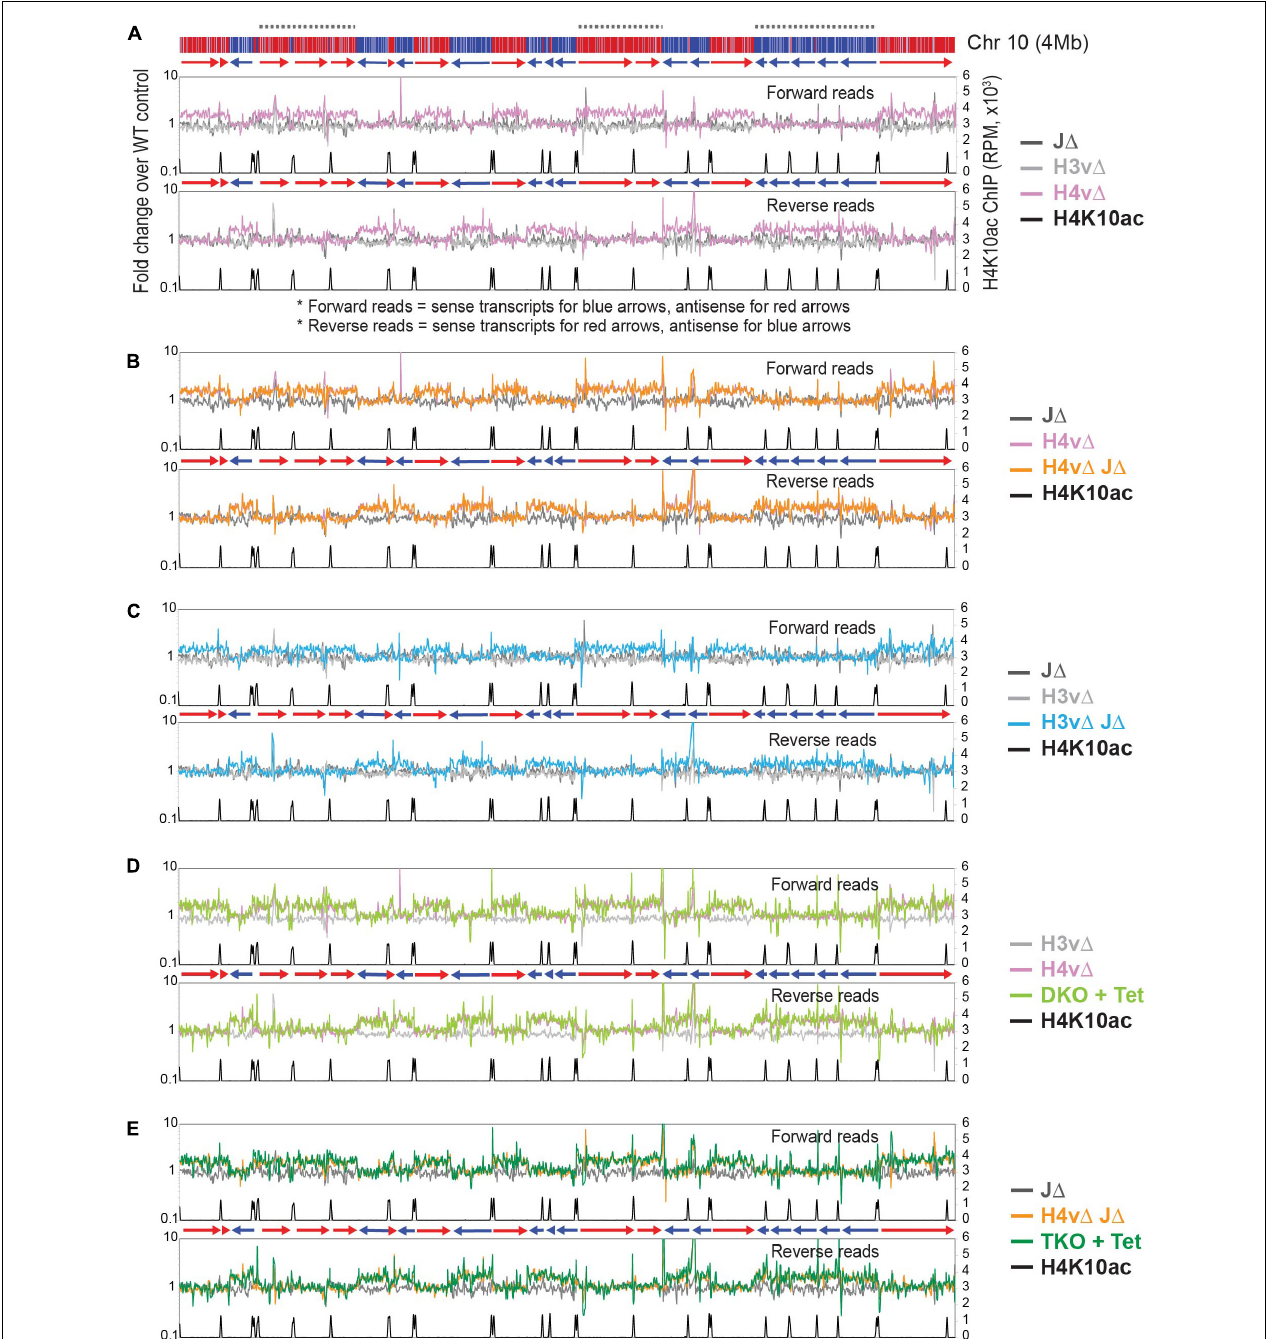
FIGURE 2 | H4v is the major transcription termination signal with a secondary role of H3v and J. Global transcription was examined by rRNA-depleted stranded RNA-seq and the sequence reads mapped to the T. brucei Lister 427 genome. Forward and reverse reads were analyzed separately with sliding windows (5-kb bin, 1-kb step). Forward reads represent sense transcripts in reverse orientation (blue arrows, blue PTUs moving from right to left) and antisense transcripts in forward orientation (red arrows, red PTUs moving from left to right). Fold changes of reads per million mapped reads (RPM) values between WT and each of KO mutant are plotted for all chromosomes. Chromosome 10 is shown as an example. Diagram of chromosome 10 is shown on top: PTUs are shown in red and blue bars with arrow heads indicating transcription direction. Dotted lines are regions containing multiple head-to-tail (HT) PTUs in the same direction. Primary y -axis is a fold change of RPM values of each mutant compared to WT. Secondary y -axis is RPM values obtained from H4K10ac ChIP seq. H4K10ac ChIP raw reads obtained from the Cross lab (Siegel et al., 2009) were mapped to the Lister 427 genome with the Bowtie 2. The following KO mutants are compared in each plot: (A) J (cid:49) , H3v (cid:49) , and H4v (cid:49) . (B) J (cid:49) , H4v (cid:49) , and H4v (cid:49) J (cid:49) . (C) J (cid:49) , H3v (cid:49) , and H3v (cid:49) J (cid:49) . (D) H3v (cid:49) , H4v (cid:49) , and Tet-treated DKO (H3v (cid:49) H4v (cid:49) ). (E) J (cid:49) , H4v (cid:49) J (cid:49) , and Tet-treated TKO (H3v (cid:49) H4v (cid:49) J (cid:49) ).